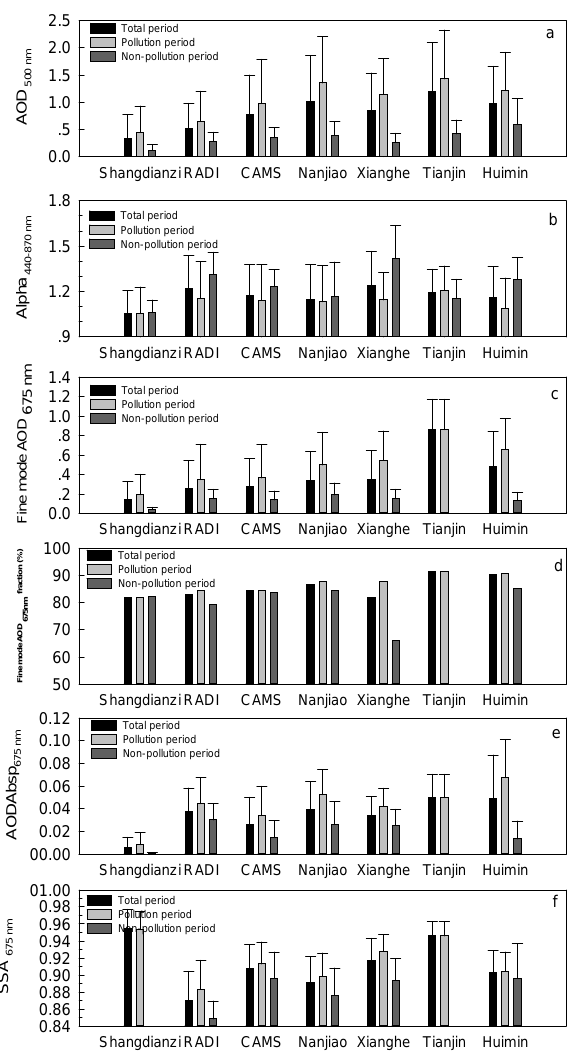
Fig. 6. Means of aerosol optical properties during the total period (January 2013), pollution period (daily PM 2 . 5 ≥ 75µgm − 3 ) , and non-pollution period (daily PM 2 . 5 ≤ 75µgm − 3 ) at each site. (a) AOD at 500nm, (b) Alpha between 440–870nm, (c) Fine mode AOD at 675nm, (d) Fine mode AOD fraction at 675nm (Fine mode AOD 675nm /Total mode AOD 675nm ) , (e) Absorption AOD at 675nm, (f) Single scattering albedo at 675nm (SSA 675nm )